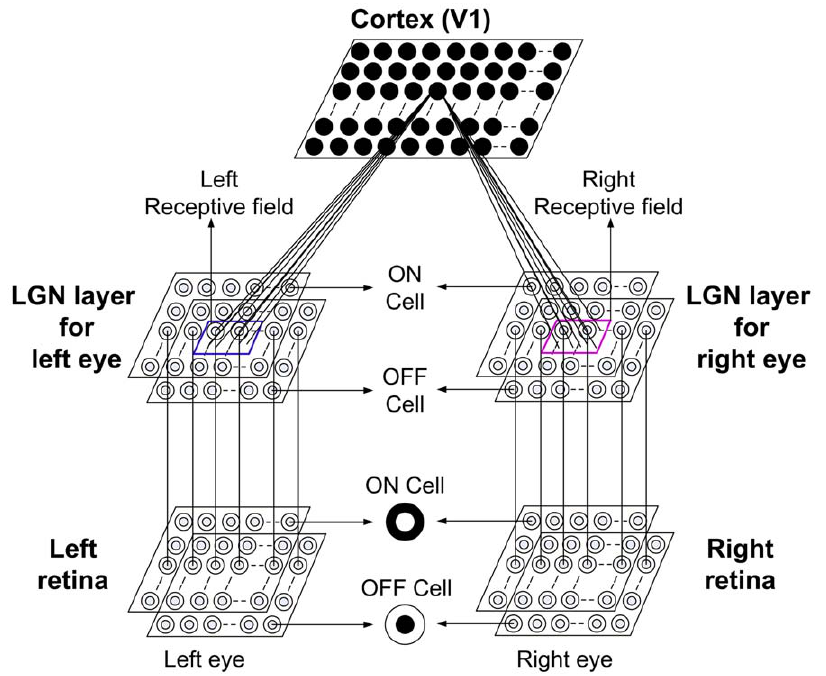
Figure 1. Three layer visual pathway model. (i) Layer 1: left and right retina/eye (each M x M overlapping ON and OFF retinal cells), (ii) Layer 2: left and right eye specific LGN layers (each M x M overlapping ON and OFF LGN cells), and (iii) Layer 3: IV layer of V1 in cat (N x N cortical cells). Each cortical cell in the model receives thalamic projections from each 13 6 13 left and right eye specific LGN cells centered at their retinotopic center. These thalamocortical connections define left and right RFs. We have used N=50 and M=30.